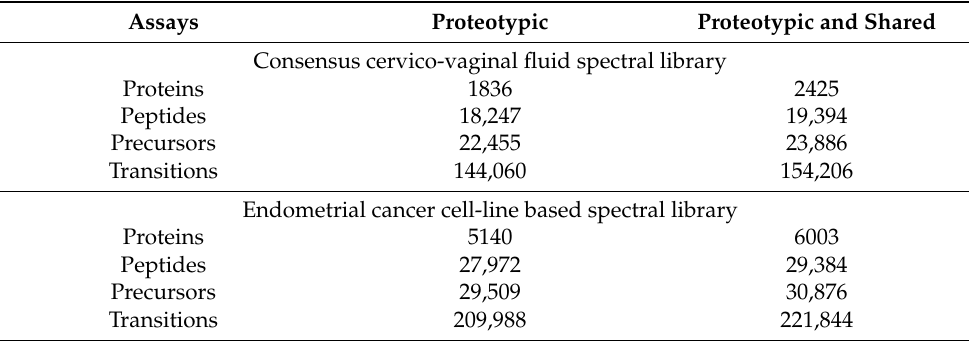
Table 3. Assay statistics for the consensus cervico-vaginal fluid and endometrial cancer cell-based spectral libraries at a protein FDR of